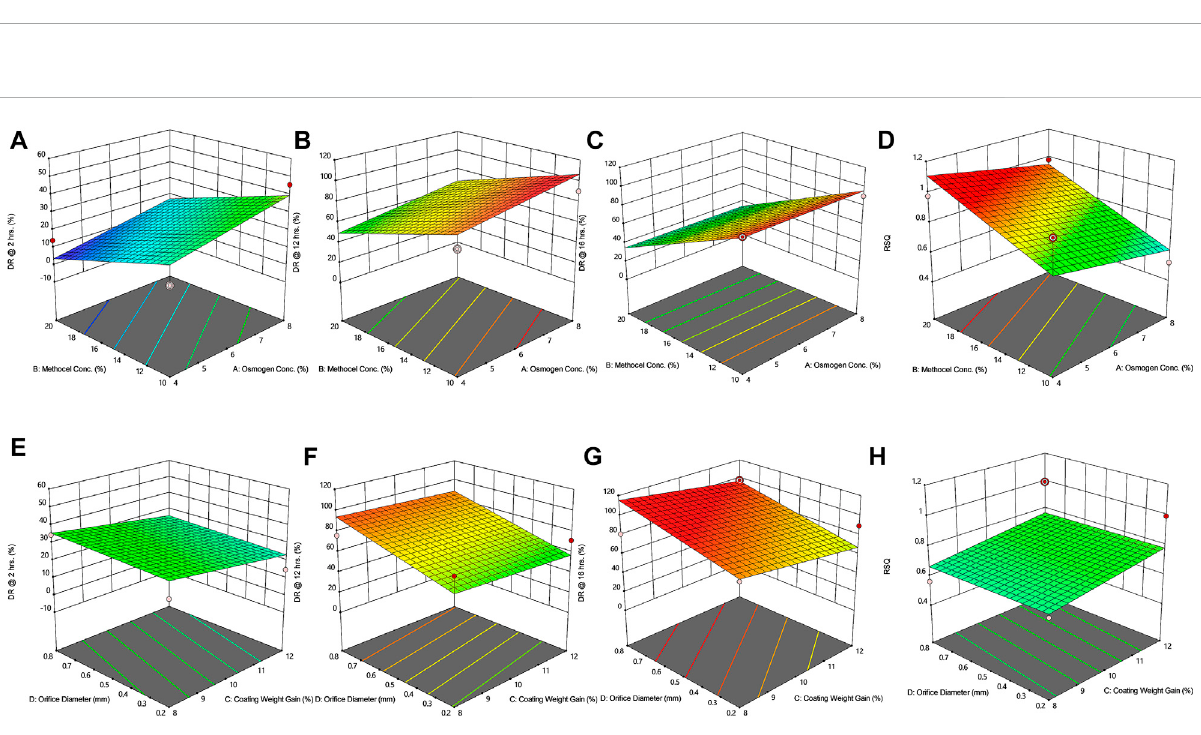
FIGURE 4 Response surface plots (3D) showing the effect of osmogen concentration (X 1 ), Methocel ™ K4M concentration (X 2 ), coating weight gain (X 3 ) and ori fi ce diameter (X 4 ) on the release of F4 formulation (A) at 2 h (B) at 12 h (C) at 16 h (D) on zero-order release coef fi cient ( r 2